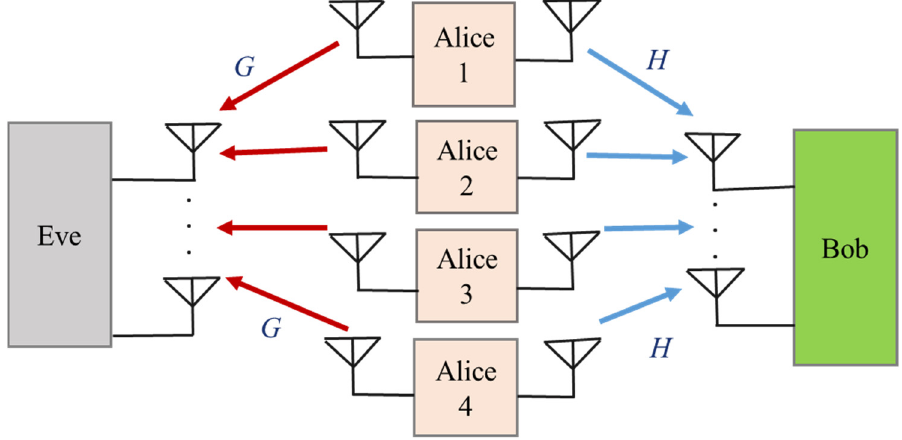
Figure 4. A system model for a multiple-access channel.